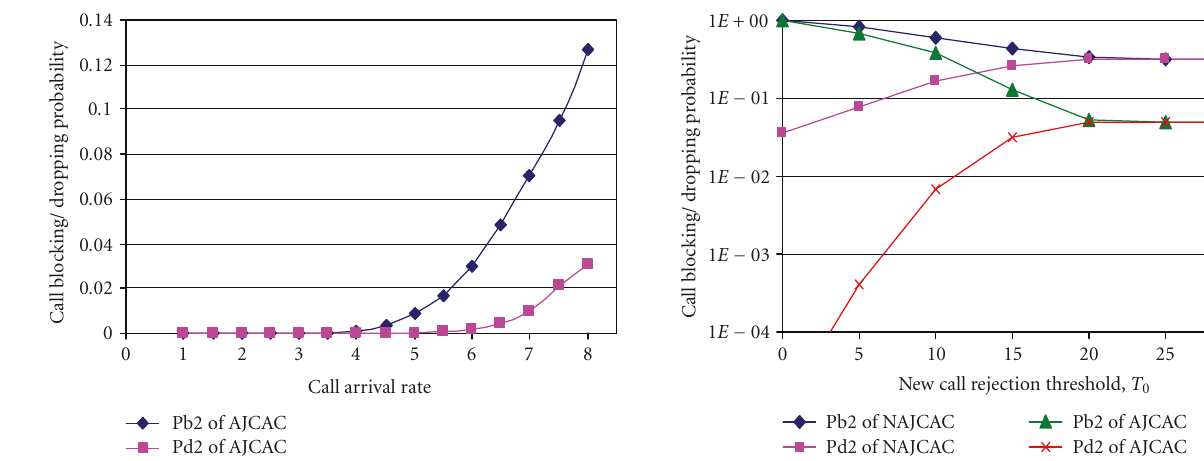
Figure 10: E ff ect of varying the new call rejection threshold, T 0 on the new call blocking probability and hando ff call dropping proba- bility of class-2